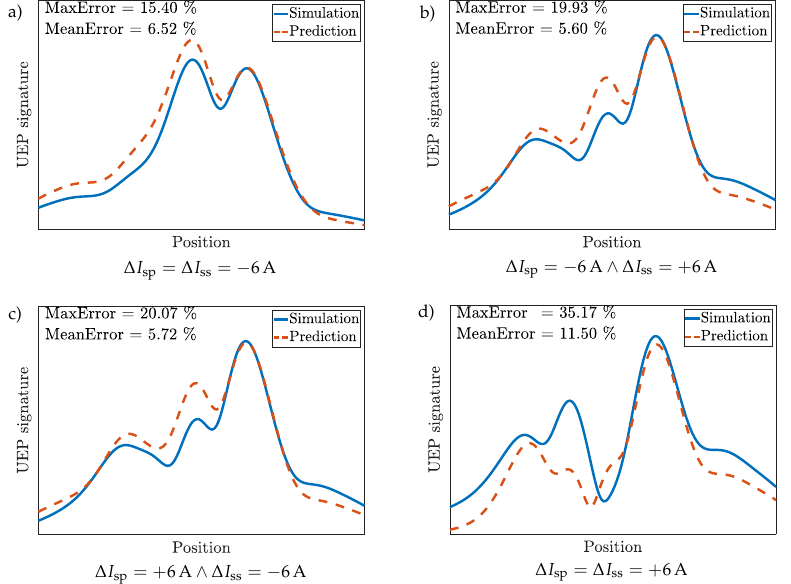
Figure 7. Scenario 2 (bare steel hull): Prediction example of the magnitudes of the UEP signature for changing the impressed currents (subfigure ( a – d )) of the ICCP electrodes at the stern using the prediction formulae of the Equations (8)–(10) and the polarization curve of bare steel for the hull and sea chests. Here, compared to the prediction accuracy for the HY-80 steel in Figure 6 higher deviations for the predicted UEP signatures are present, which can be explained by the stronger influence of the UEP signature generated by the nonlinear corrosion process on the total UEP